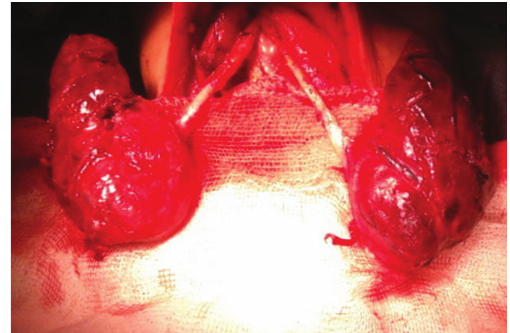
F 2: Agenesis of the thyroid isthmus at surgical